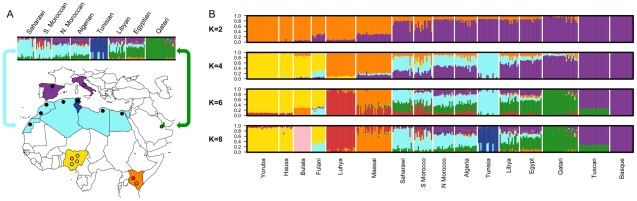
Map of samples and population structure of North Africa and neighboring populations.A) On the map, star symbols indicate the location of new population samples and circles indicate previously published samples. The decreasing proportions of Maghrebi ancestry is indicated in a west-to-east gradient of blue across North Africa. An unsupervised clustering algorithm, ADMIXTURE
[25] was used to analyze population structure among 13 African, 2 European and 1 Near Eastern populations based on approximately 300 K autosomal SNP loci in common. The two main gradients of ancestry in North Africa (at k = 8), Maghrebi and Near Eastern, are emphasized with arrows. Other population colors in open circles match the colors displayed in the population structure analysis. B) We plot the full dataset assuming k = 2,4,6,8 ancestral populations. k = 10 and log likelihoods are presented in Figure S1.